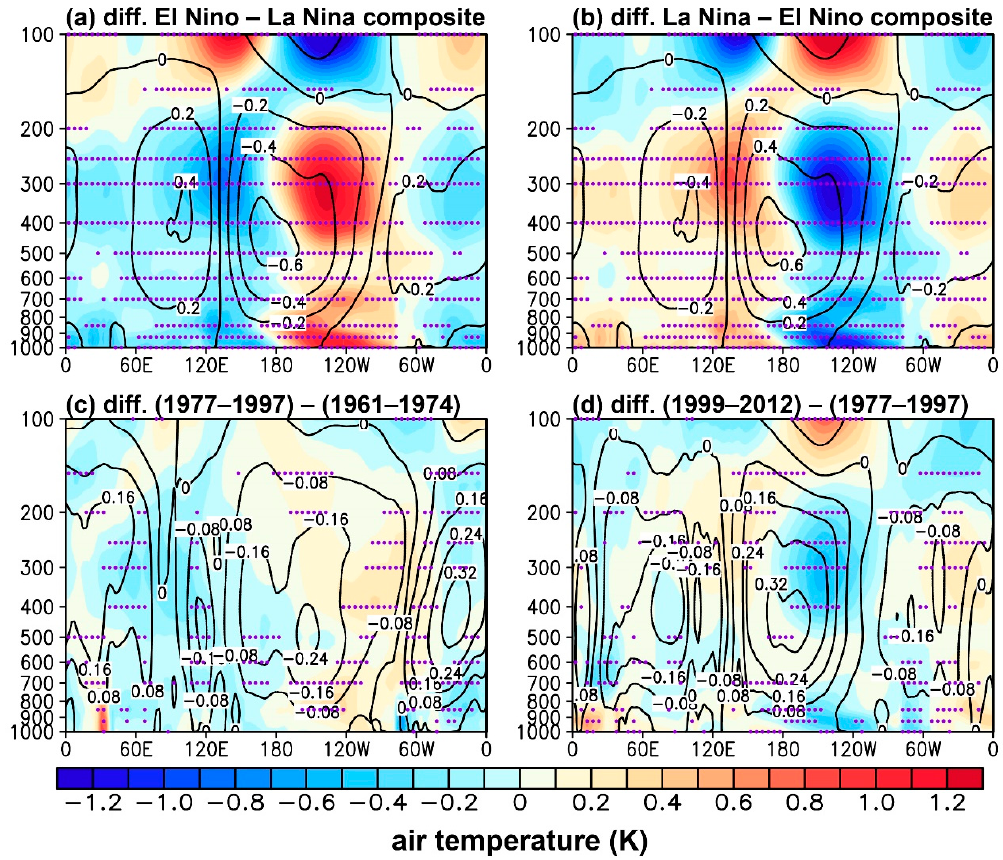
Figure 8. Differences in the zonal circulation (contours; 10 − 6 s − 1 ) and inhomogeneous air temperature (shading; K) along the equator (5° S–5° N) between ( a ) El Niño and La Niña, ( b ) La Niña and El Niño, ( c ) the periods 1961–1974 and 1977–1997, and ( d ) the periods 1977–1997 and 1999–2012. The composites of zonal circulation and inhomogeneous air temperature which are both statistically significant at the 5% confidence level are dotted in purple.